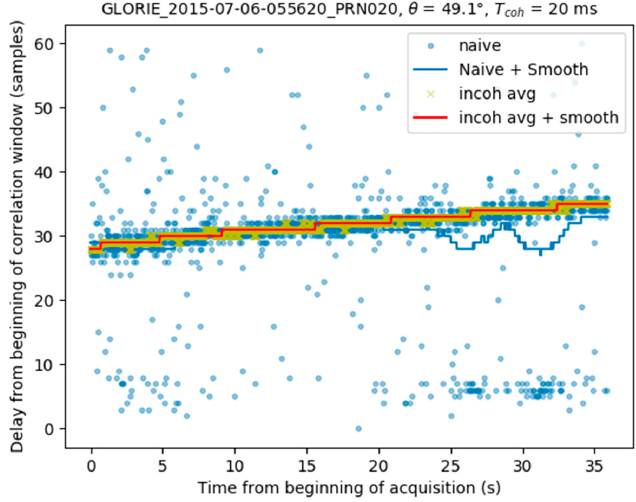
Figure 6. Peak detection using naïve, naïve + smoothing, incoherent averaging and incoherent averaging + smoothing methods. Aircraft height above ground level is ~500 m.